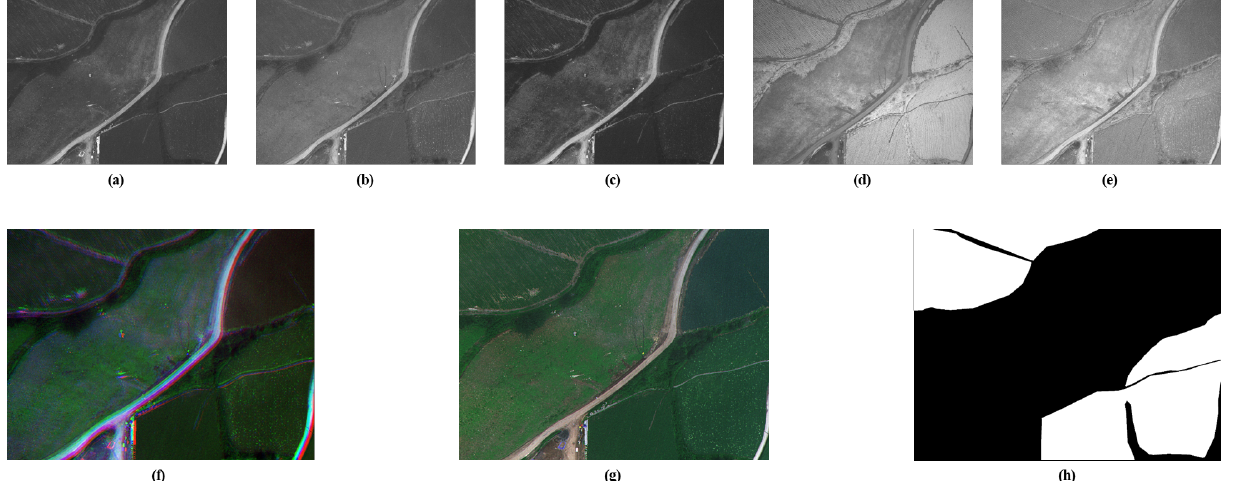
Figure 3. Registration from multi spectral images to an RGB image. Using ECC transformation, ( a ) blue, ( b ) green, ( c ) red, ( d ) red edge, and ( e ) near-infrared wavelength values in gray scale are aligned to ( g ) RGB image. ( f , h ) is an example of incorrect registration and pixel-wise ground truth